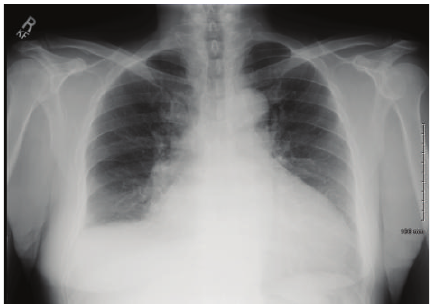
Figure 1: CXR revealed mild blunting of right costophrenic sulcus without consolidation or infiltrates.